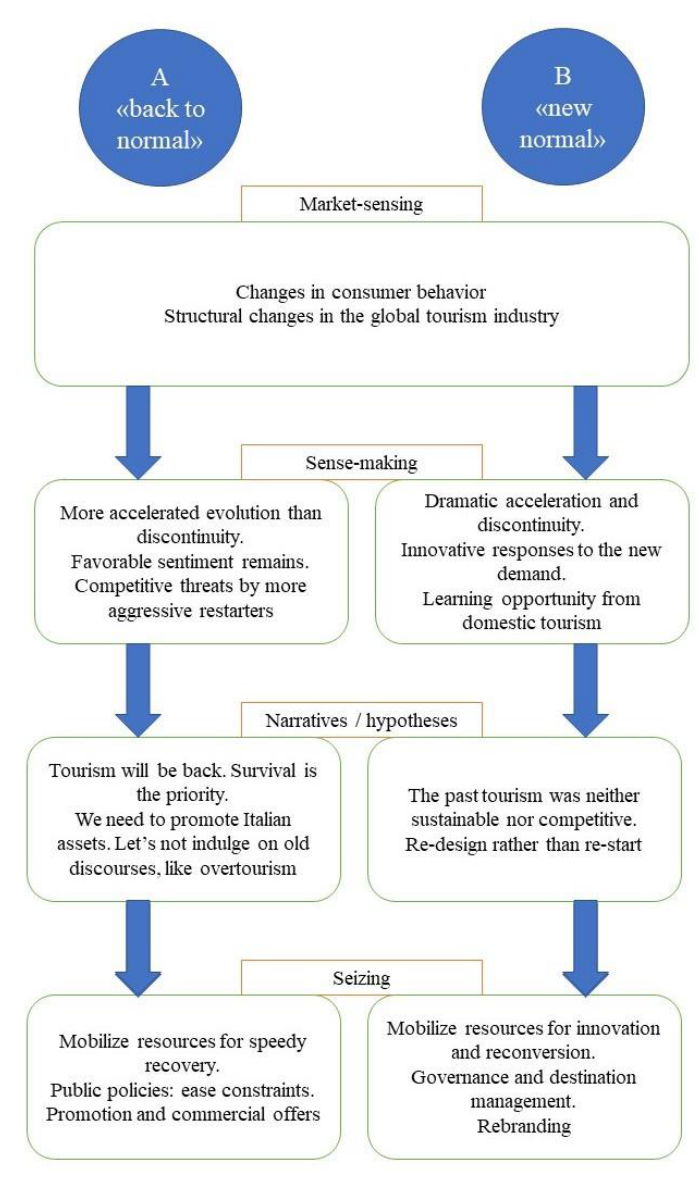
Figure 1: Discourses on Tourism